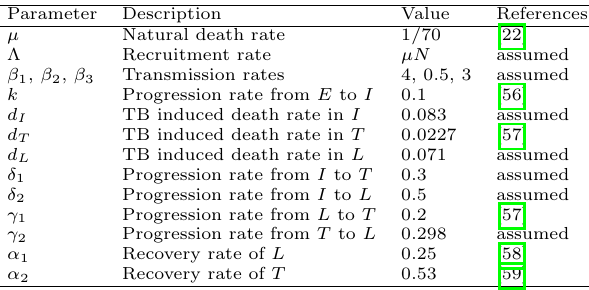
Table 1. Parameters descrip- tion and values